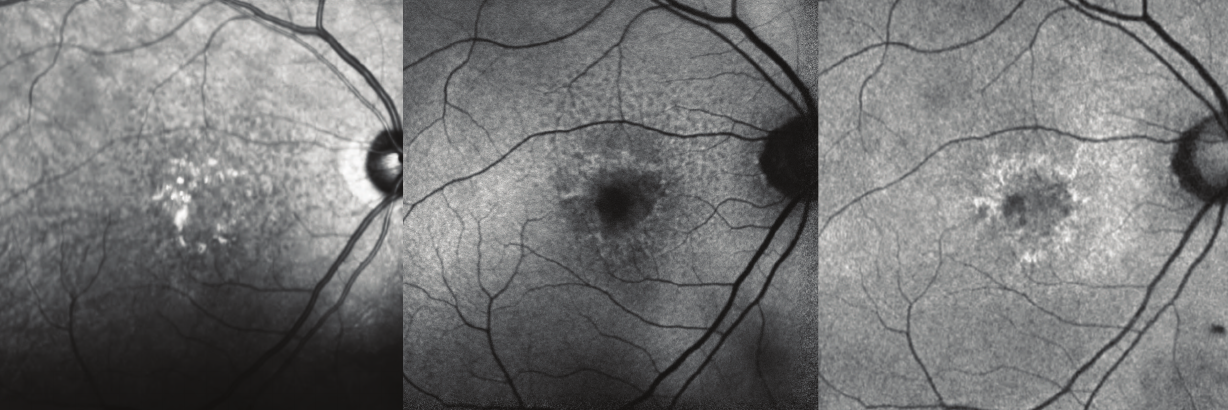
Figure 3. Comparison of near-infrared reflectance (NIR-R), blue-light, and green-light short-wave fundus autofluorescence (SW-AF) images of the right eye in a patient with dry age-related macular degeneration. Left: NIR-R (Spectralis) image. Middle: Blue light (Spectralis) SW-AF image. Note the hypo-autofluorescence of the optic disc and the foveal center. Right: Green light (Optos) SW-AF image. Note the less hypoautofluorescent appearance of the optic disc and foveal center. The subretinal drusenoid deposits are readily visible with the NIR-R and blue SW-AF while poorly visible with green light SW-AF.